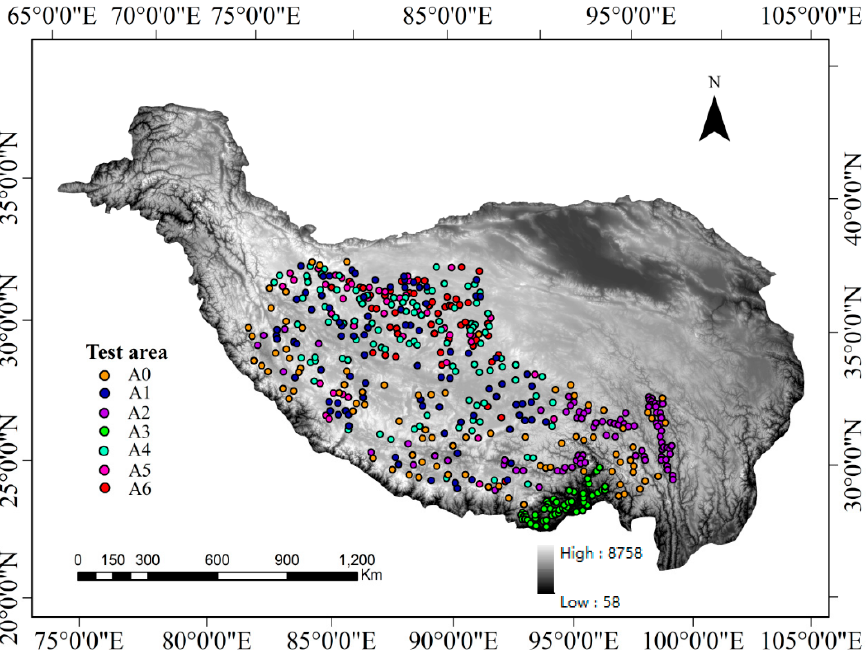
Figure 2. Location distribution of samples in the southwestern Tibetan Plateau. A0: High relief ex- tremely high altitude mountain; A1: High altitude plain; A2: Intermediate relief high mountain; A3: Intermediate relief middle mountain; A4: Low relief extremely high mountain; A5: Extremely high altitude plain; A6: Extremely high altitude high-hill.